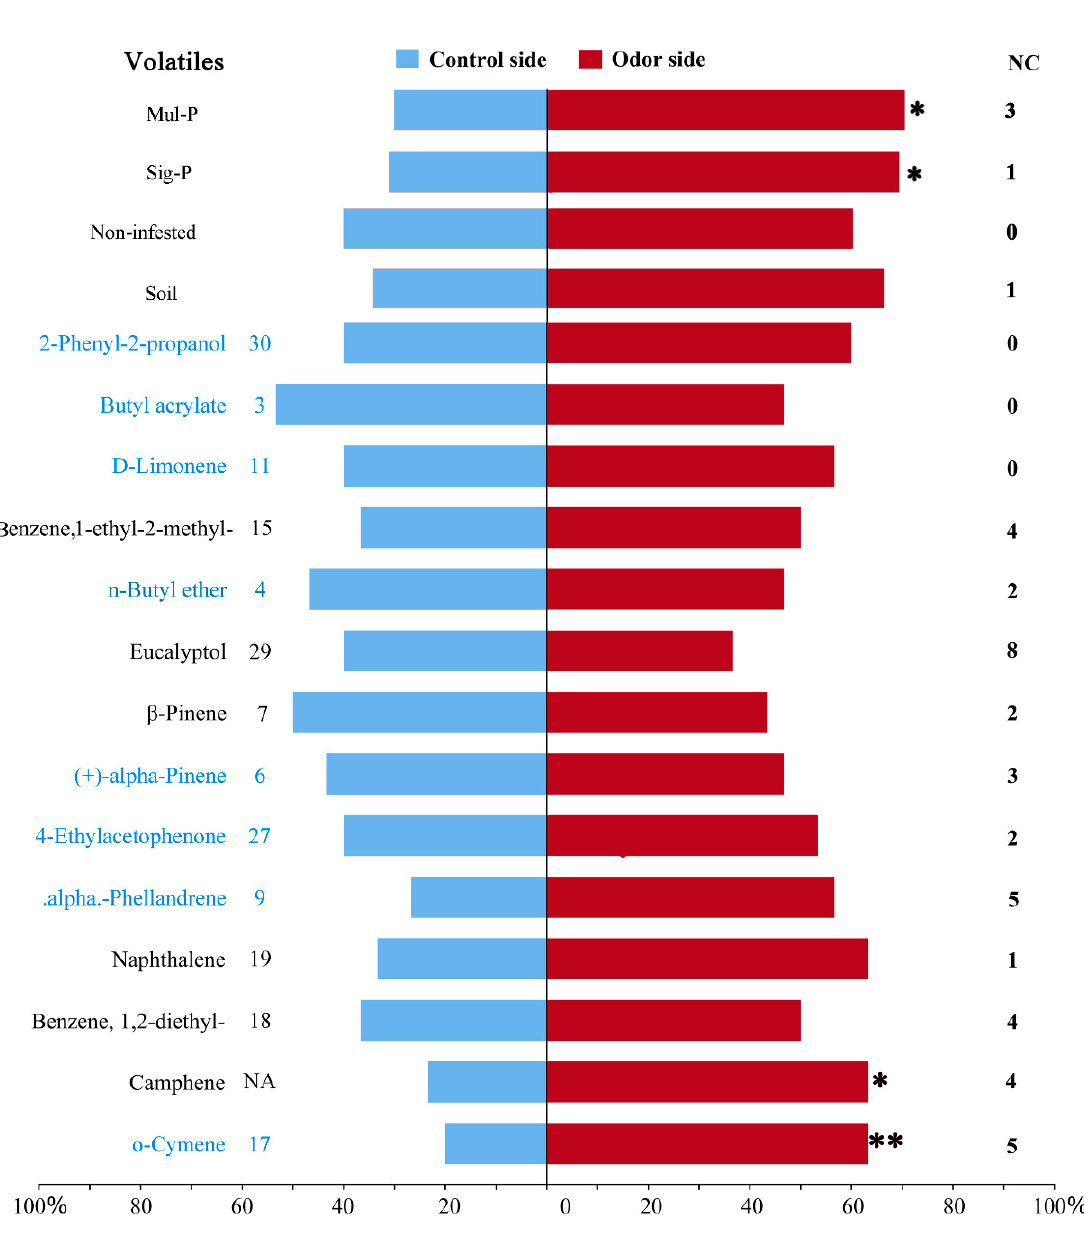
Figure 3. Y-tube olfactometer bioassay of eucalyptus trunk and forest floor humus volatiles. NC means no choice, blue volatiles were GC-EAD-active compounds, * denotes significant differences at p < 0.05, ** denotes significant differences at p < 0.01. Numbers beside compounds are the same as Table 1. NA means no compound in Table 1.